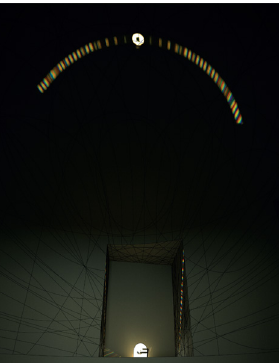
Fig. 3 The projection of the rainbow using the device described by Maignan (digital reconstruction by the